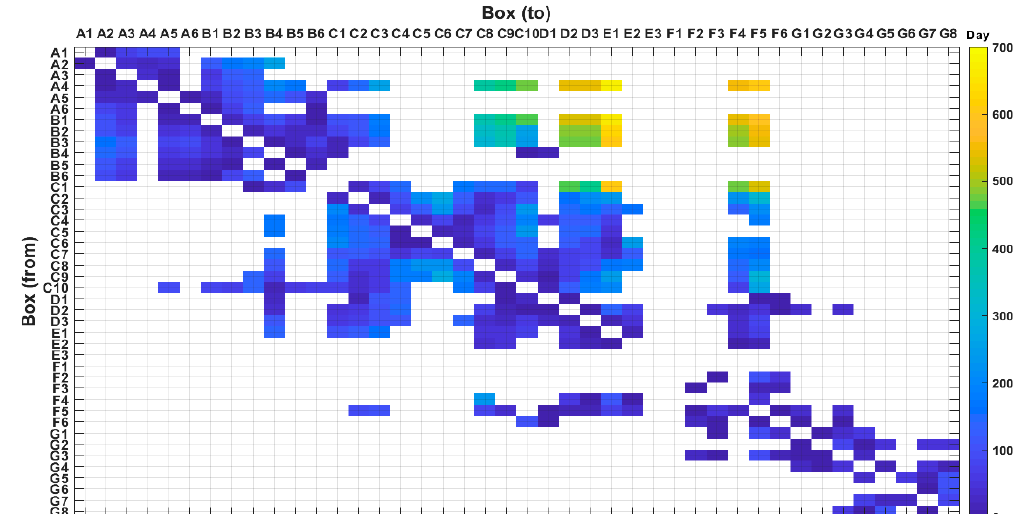
Figure 10. Mean transit time of anticyclonic eddies connecting the 42 boxes of the WMED. Each box extends over a 1° × 1° cell. Anticyclonic eddy tracks data refer to the 1993–2016 period.